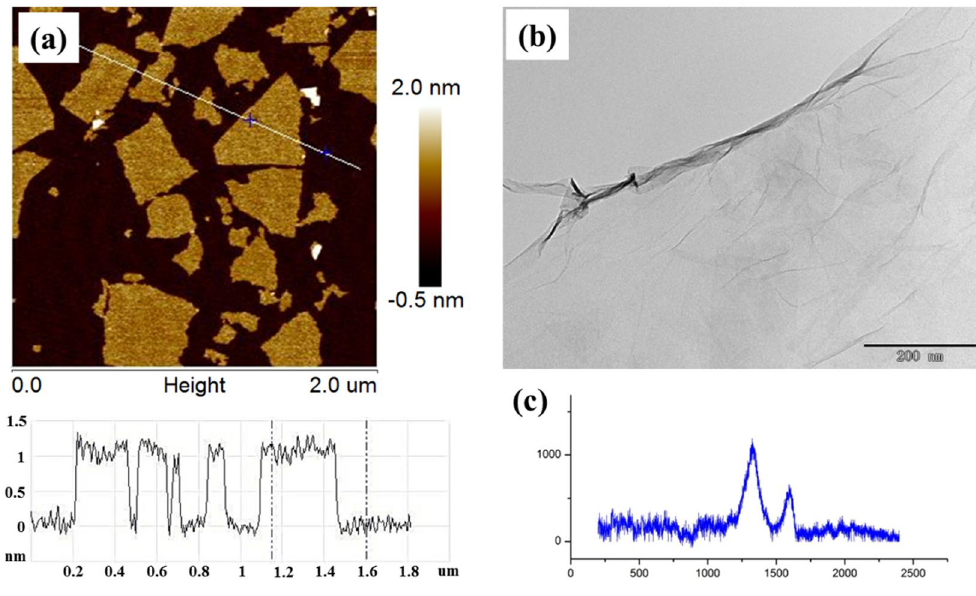
Figure 1. Characterization of GO: AFM ( a ), TEM ( b ), and Raman spectra ( c